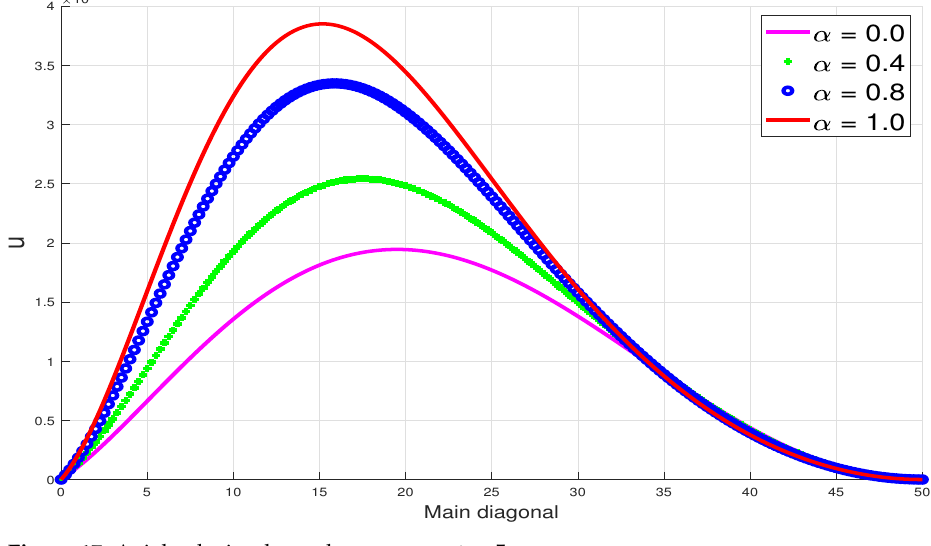
Figure 17. Axial velocity dependence on α at t = 5.